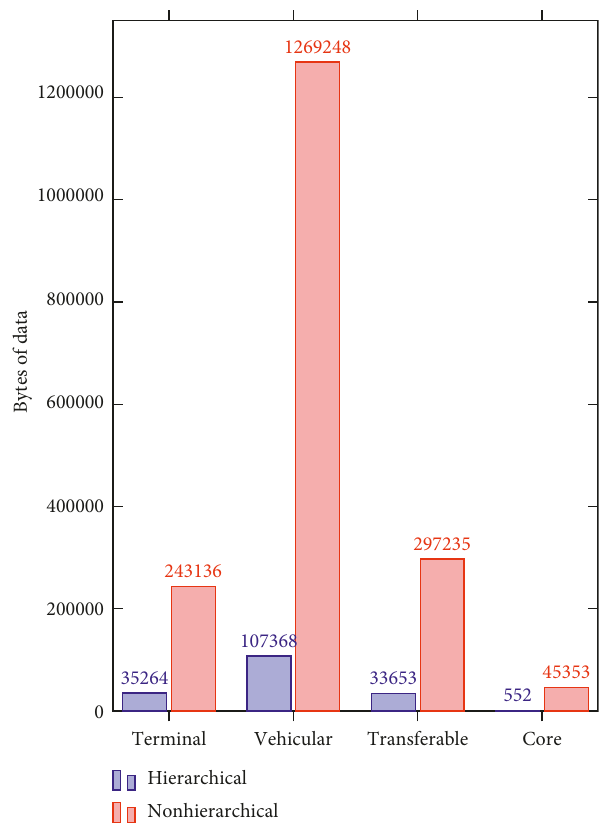
Figure 12: Data sent in the hierarchical and nonhierarchical DTN management service implementations of the Anglova